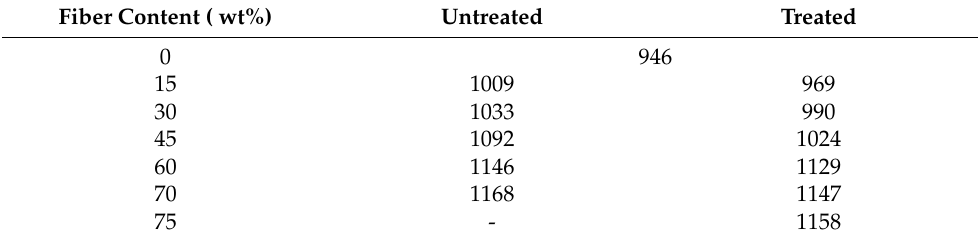
Table 1. Density of the samples produced (+/ − 1 kg/m 3 ).